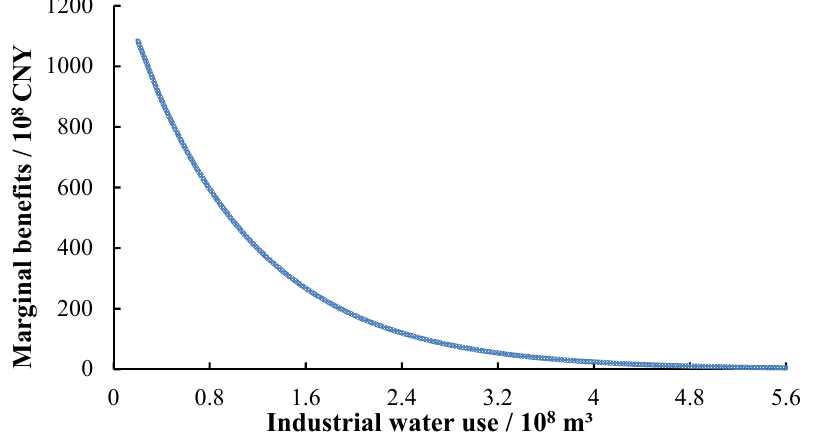
Figure 4. The marginal benefits of industrial water in Tianjin.